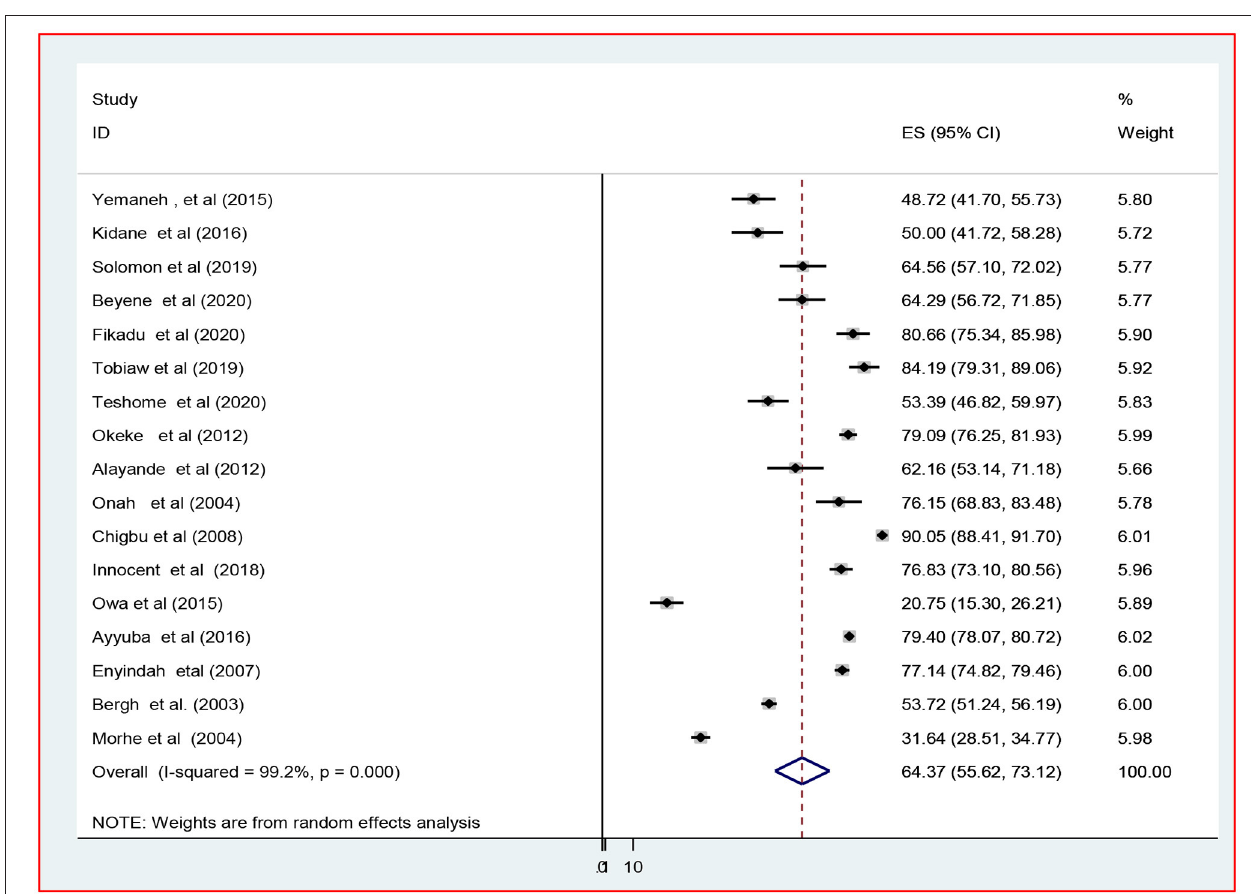
FIGURE 3 | The pooled prevalence of episiotomy practice among primiparous women in Africa,